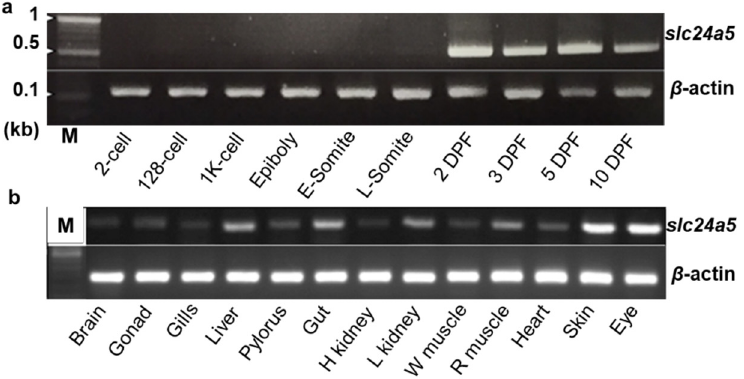
Figure 9. slc24a5 RNA expression in kawakawa. ( a ) Stage dependent mRNA expression (embryos at different stages of developmental time point). ( b ) Tissue specific mRNA expression (Adult, N-6). RT-PCR was done on cDNA derived from adult tissues (brain, gonad, gills, liver, pylorus, gut, kidney, muscle, heart, skin, and eye) and embryos at different developmental time points (0.1–10 dpf) using oligonucleotide primers (TD_F and TD_R results in expected amplicon of 501 bp) that flanked the specific slc24a5 in kawakawa. Positive controls ‘ β -actin’ transcripts ( β -act-F1 and β -act-R1 results in amplicon of 105 bp) were present in all selected samples including different tissues from adults, and embryos at different stages of developmental time point. The molecular size of the marker (50 base pair DNA ladder) is shown on the left. M: molecular marker; kb: kilobase; dpf: days post fertilization.